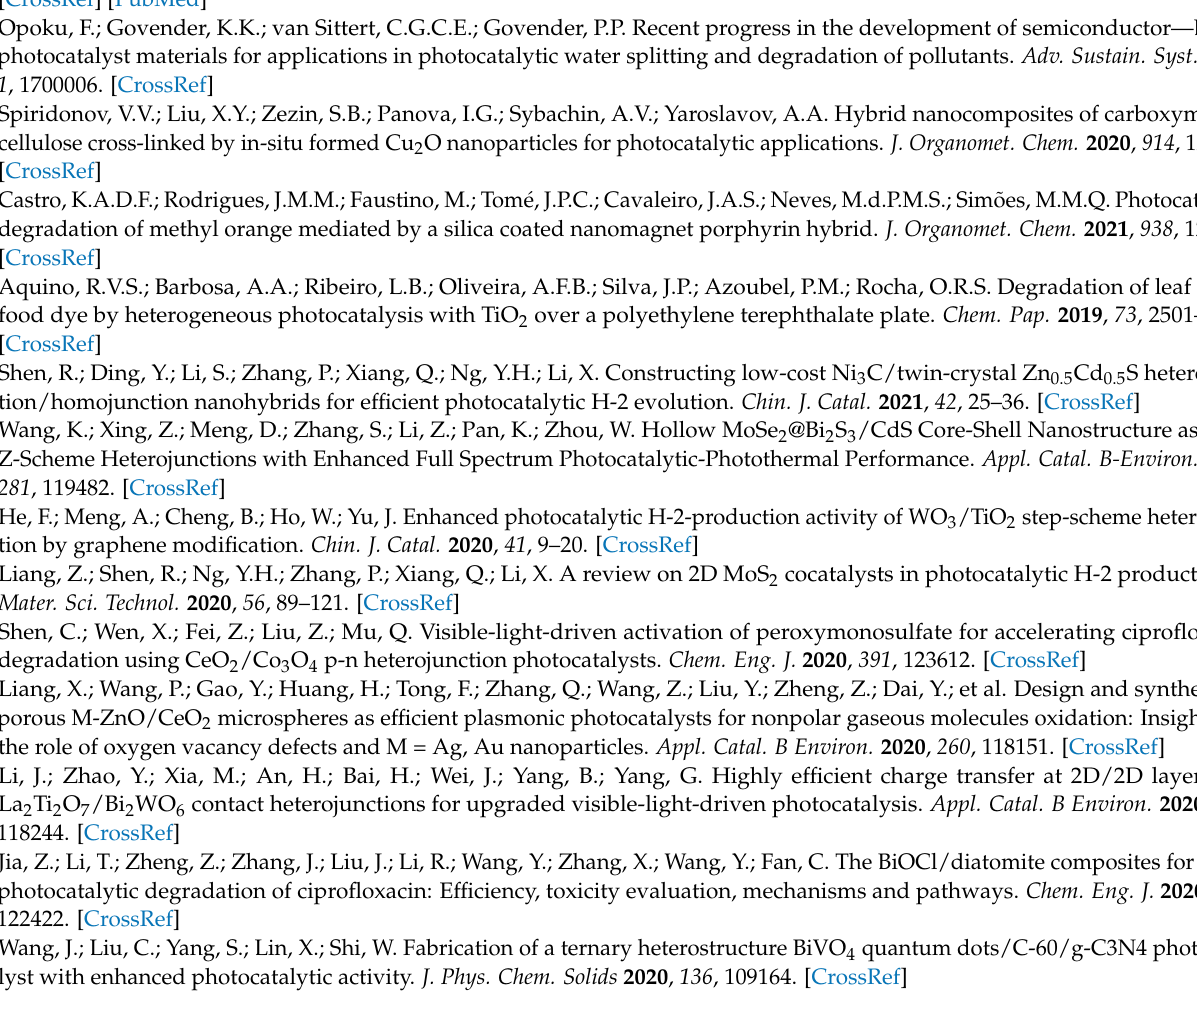
before and after cyclic experiment. Figure S5: The equivalent circuit diagram of sample. Table S1: EIS fitting data of sample. Table S2: The corresponding report of Bi2WO6, BiOCl and composite photocatalysts for RhB degradation